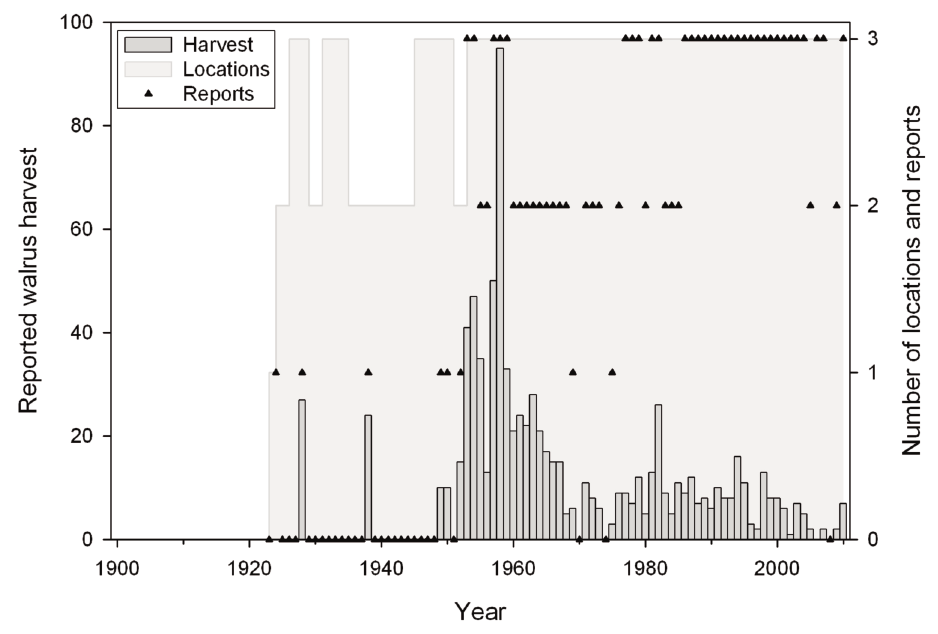
Fig. 15. Catches by Inuit and shore-based traders, and community reporting rates, from the Penny Strait–Lancaster Sound (PS-LS) stock of the Canadian High Arctic walrus population,